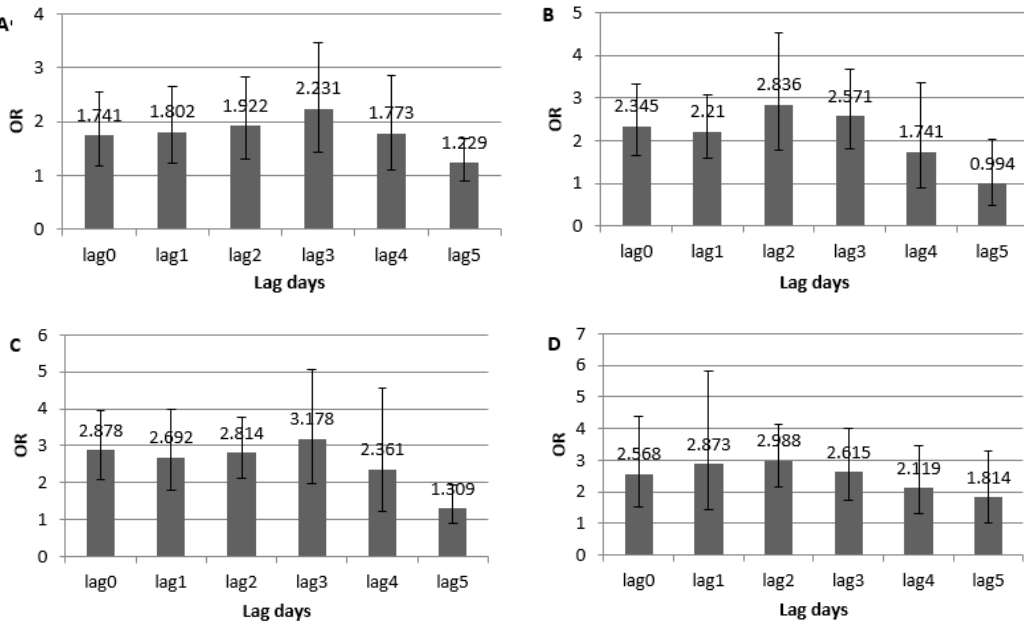
Figure 2. Odds ratio (OR) estimates of the heat waves on the hospital visits of mental illness in different lag days in Jinan. ( A ) the first heat wave; ( B ) the second heat wave; ( C ) the third heat wave; ( D ) the fourth heat wave.